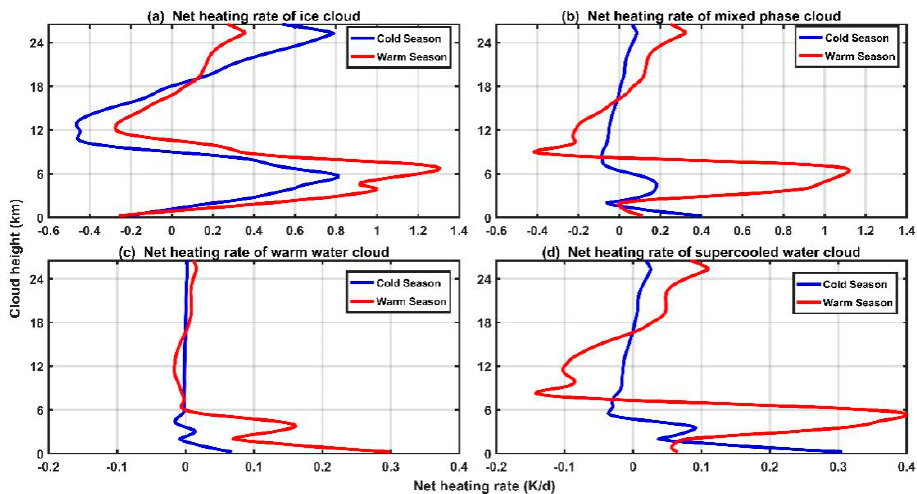
Figure 7. Vertical distribution of net heating rate in different cloud phases (( a ) represents the single-layer ice cloud, ( b ) represents the single-layer mixed cloud, ( c ) represents the single-layer warm water cloud, and ( d ) represents the single-layer supercooled water cloud).